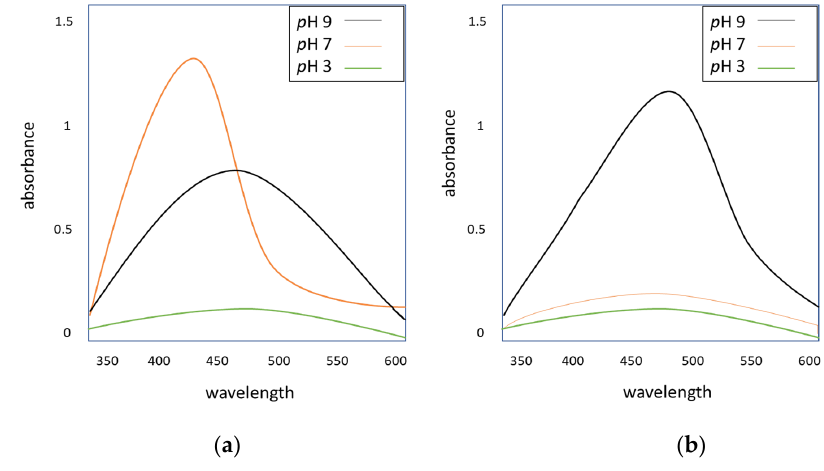
Figure 2. Effect of pH on the preparation of SNPs ( a ) for TSADE and ( b ) for TSFPE.